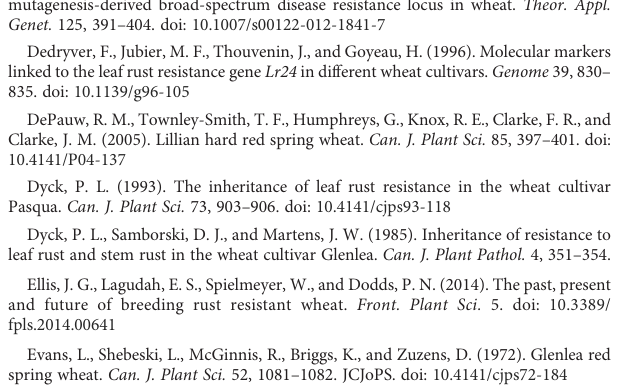
SUPPLEMENTARY TABLE 2 Genotype data of the three mapping populations (excel sheet